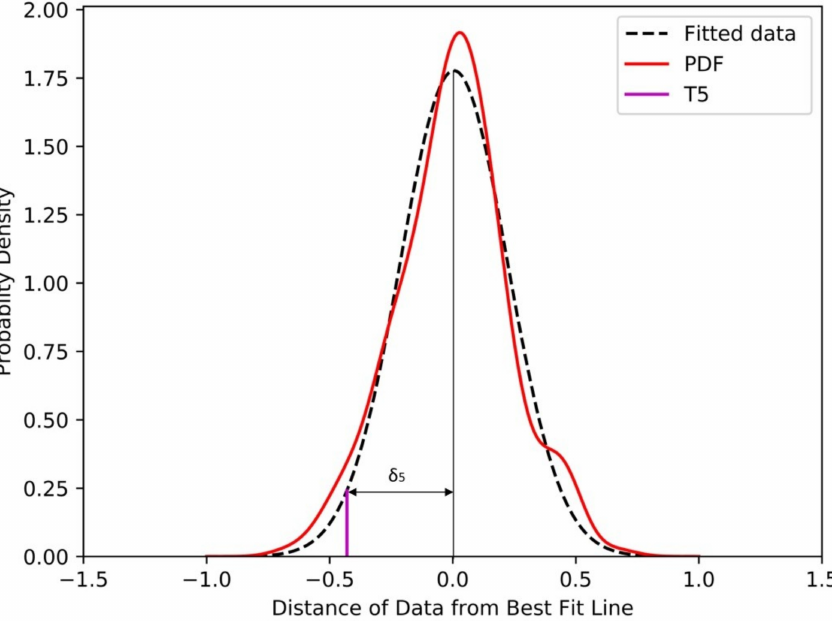
Figure 8. Probability density function of the distribution of δ I, fitted using a Gaussian